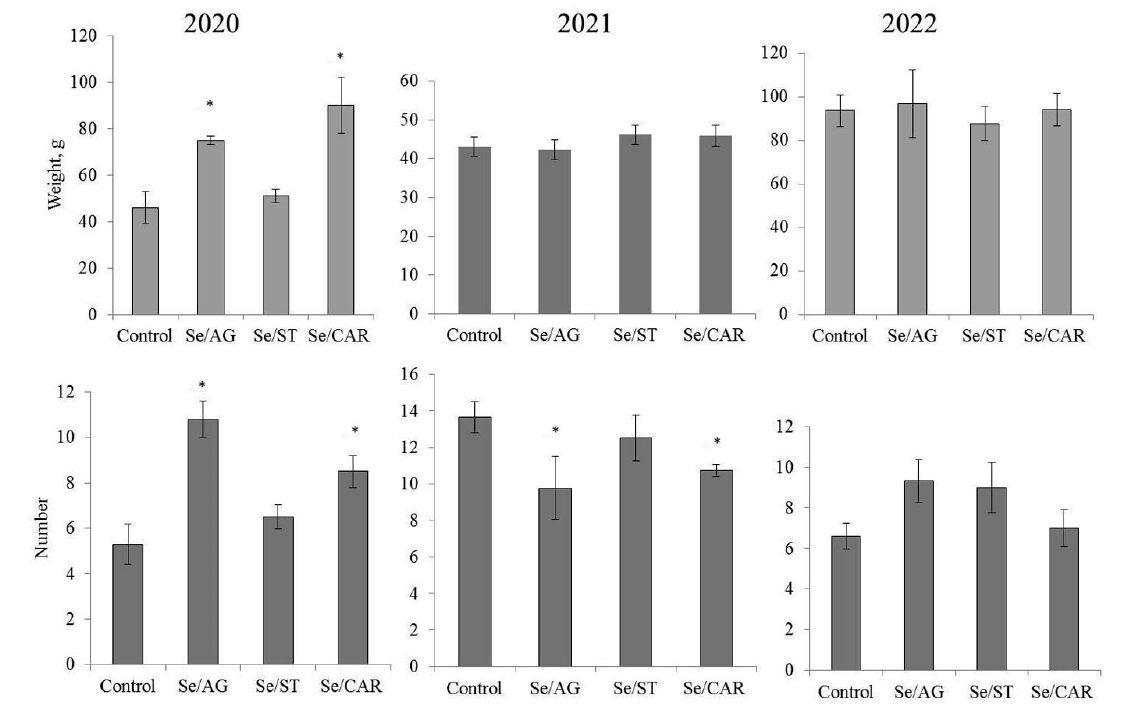
Figure 1. Results of the field experiments in 2020, 2021, and 2022 on the effect of nanopriming of tubers with three Se NCs based on the natural polymer matrices (Se/AG, Se/ST, and Se/CAR NCs, respectively) on potato productivity (average weight and number of tubers per plant). Significant differences from control according to the Mann–Whitney U-test: * p < 0.01.